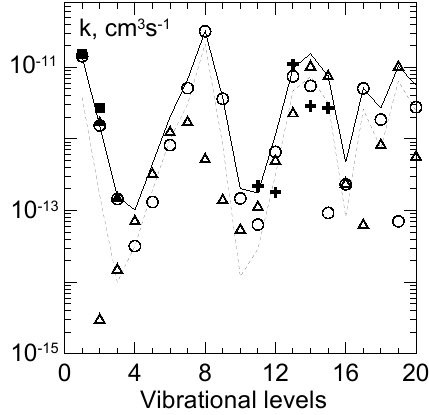
0 Fig. 11. The calculated total quenching rate coefficients of O 2 ( b 1 6 + g , v )+O 2 (X 3 6 − g , v =0) at temperatures of 155 and 300K Figure 11. The calculated total quenching rate coefficients of O 2 (b 1 Σ g+ ,v) + O 2 (X 3 Σ g– ,v=0) at (dotted and solid lines, respectively) are compared with experi- temperatures of 155 and 300 K (dotted and solid lines, respectively) are compared with mental data by Bloemink et al. (1998) (squares), Kalogerakis et experimental data by Bloemink et al. (1998) (squares), Kalogerakis et al. (2002) (solid triangles) al. (2002) (solid triangles) and Amaral et al. (2002), Slanger and and Amaral et al. (2002), Slanger and Copeland (2003) (crosses). The calculated contributions Copeland (2003) (crosses). The calculated contributions of pro- of processes (7a) and (7b) at room temperature – open triangles and circles, respectively. cesses (7a) and (7b) at room temperature – open triangles and cir- cles, respectively.